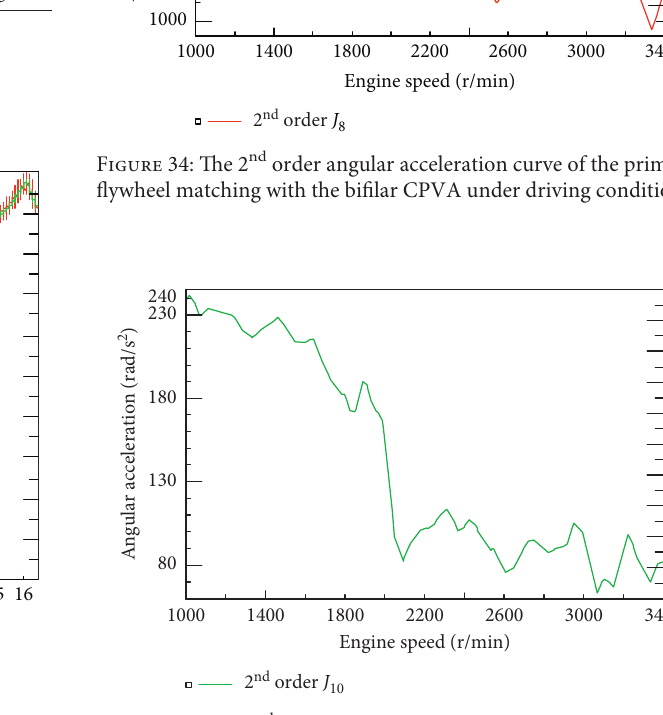
Figure 32: The rotary speed curves of the primary flywheel and the input shaft of the gearbox matching the DMF with the bifilar CPVA under driving conditions.